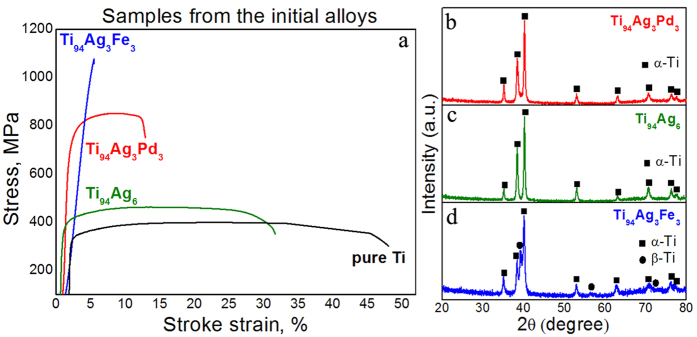
Tensile stress–strain curves of the as-cast alloys with added Ag and as-cast pure Ti (a). XRD patterns of as-cast Ti94Ag3Pd3 (b) Ti94Ag6 (c) and Ti94Ag3Fe3 (d).